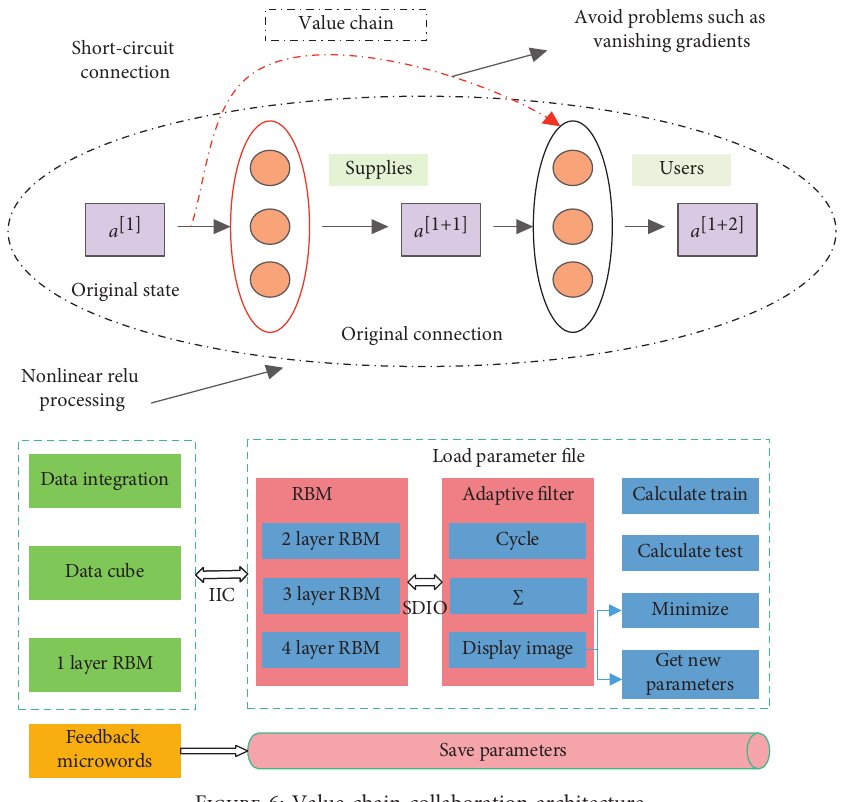
Figure 6: Value chain collaboration architecture.